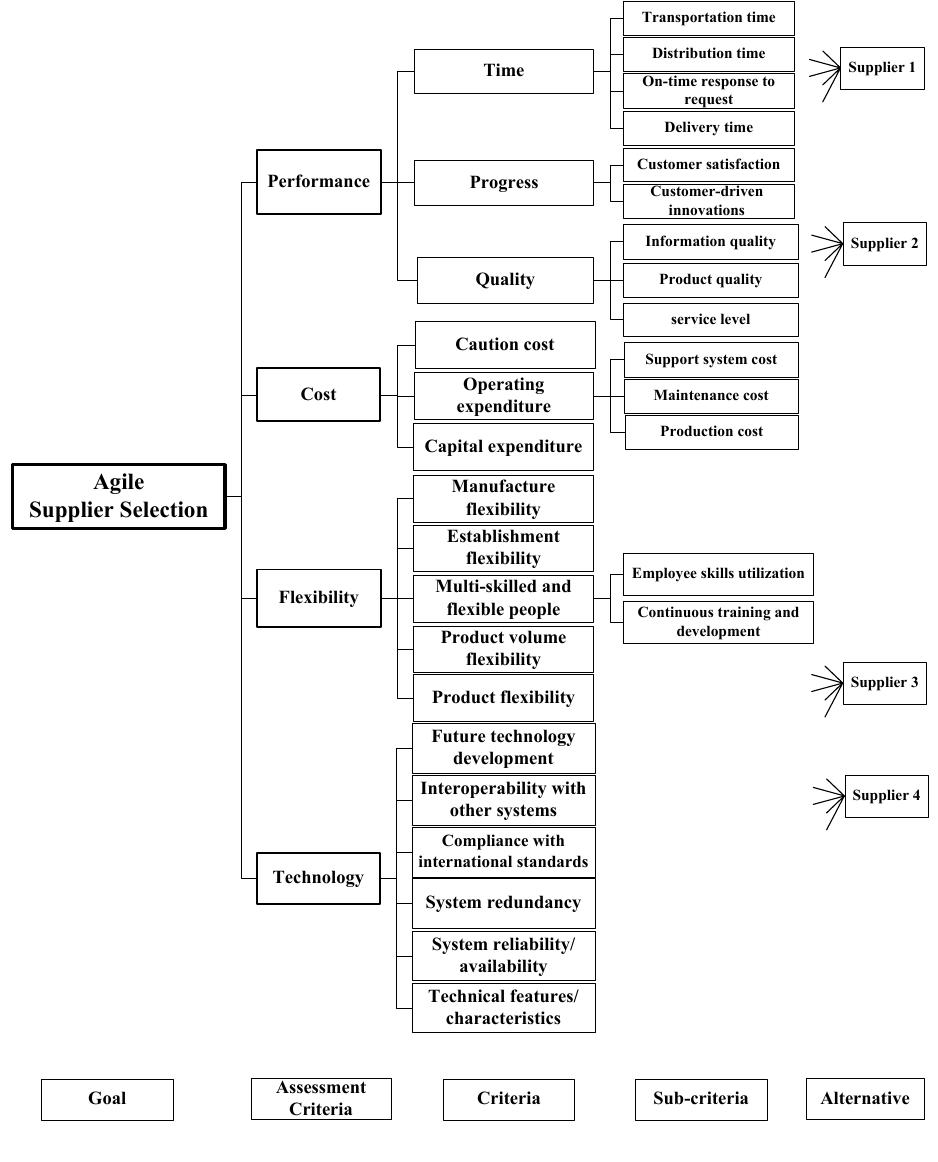
fig. 2. Problem structure, selection aspects and formulated